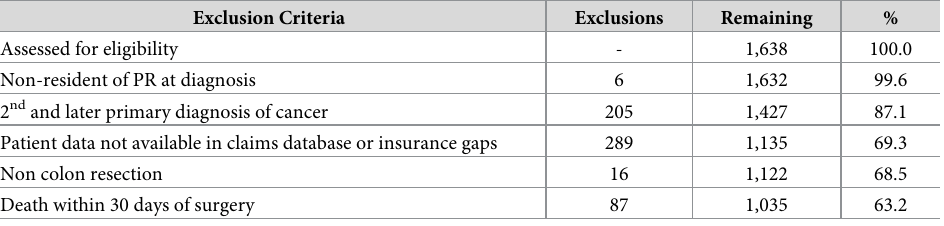
Table 1. Cohort selection criteria for patients with stage III colon cancer diagnosed during